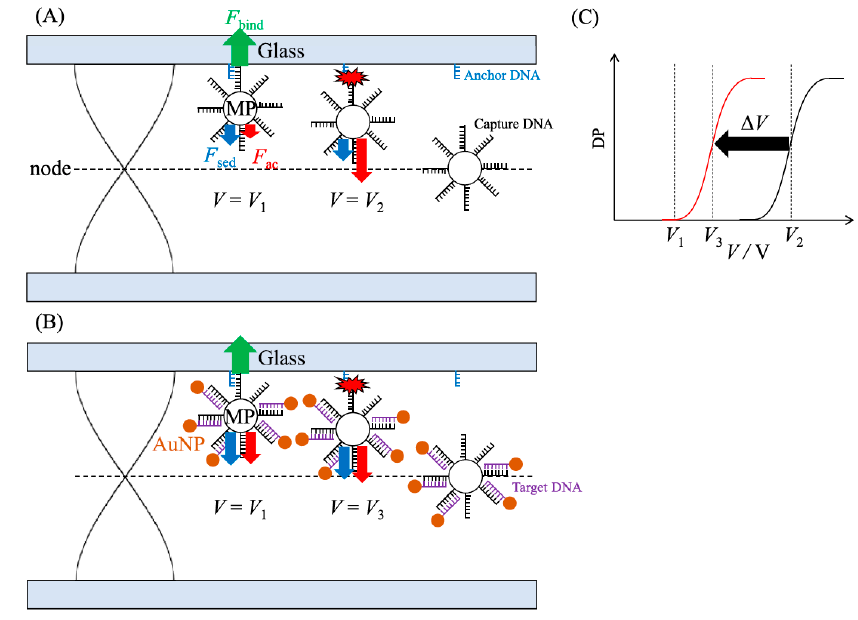
Figure 3. Particle dissociation from the substrate in the CAG field ( A ) without and ( B ) with AuNP binding to the microparticle. ( C ) Relationship between the applied voltage ( V ) and the dissociation percentage of the microparticles ( DP ). Reproduced from Ref. [55] with permission. Copyright 2022